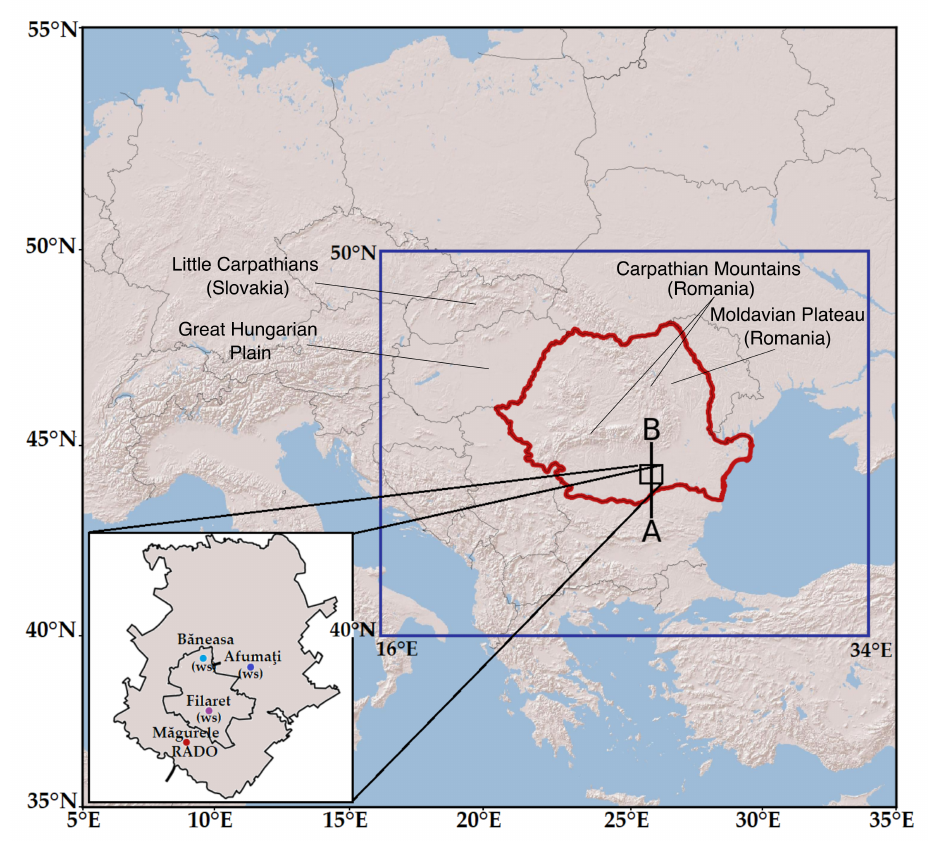
Figure 1. Study domain showing the synoptic and mesoscale (dark blue and black rectangles) areas over which analyses were performed. The red contour marks the Romanian territory. The black rectangle represents the location of Bucharest city and the measurement sites. The location of Romanian Atmospheric 3D Observatory (RADO)–M˘agurele is indicated (red dot) together with the location of B˘aneasa (blue dot), Filaret (magenta dot) and Afuma¸ti (dark blue dot) weather stations. The A–B line shows the position of the cross-section in used in Section